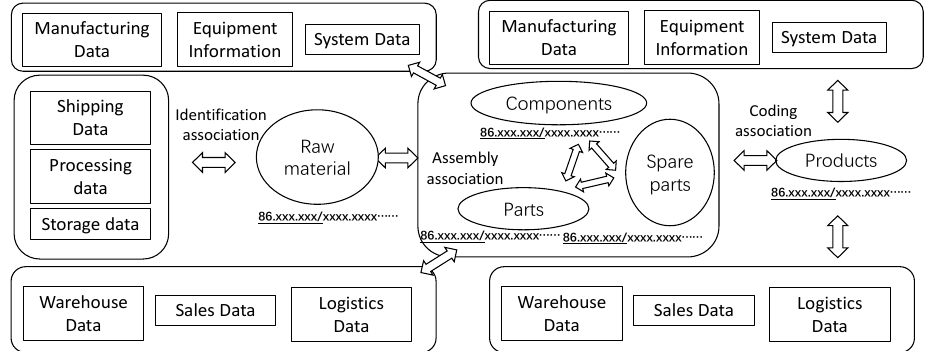
Figure 5. Workflow of the product quality traceability system.